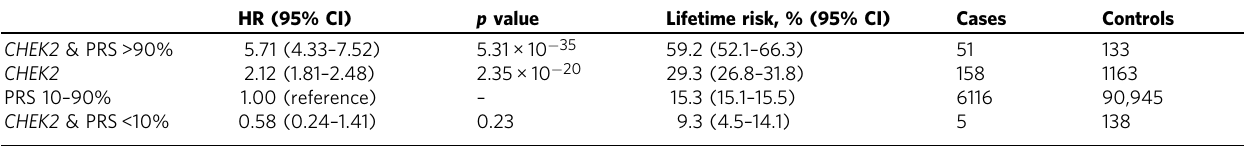
Table 4 Impact of polygenic risk score (PRS) on the breast cancer risk conferred by the CHEK2 frameshift mutation. HR (95% CI) p value Lifetime risk, % (95% CI) Cases